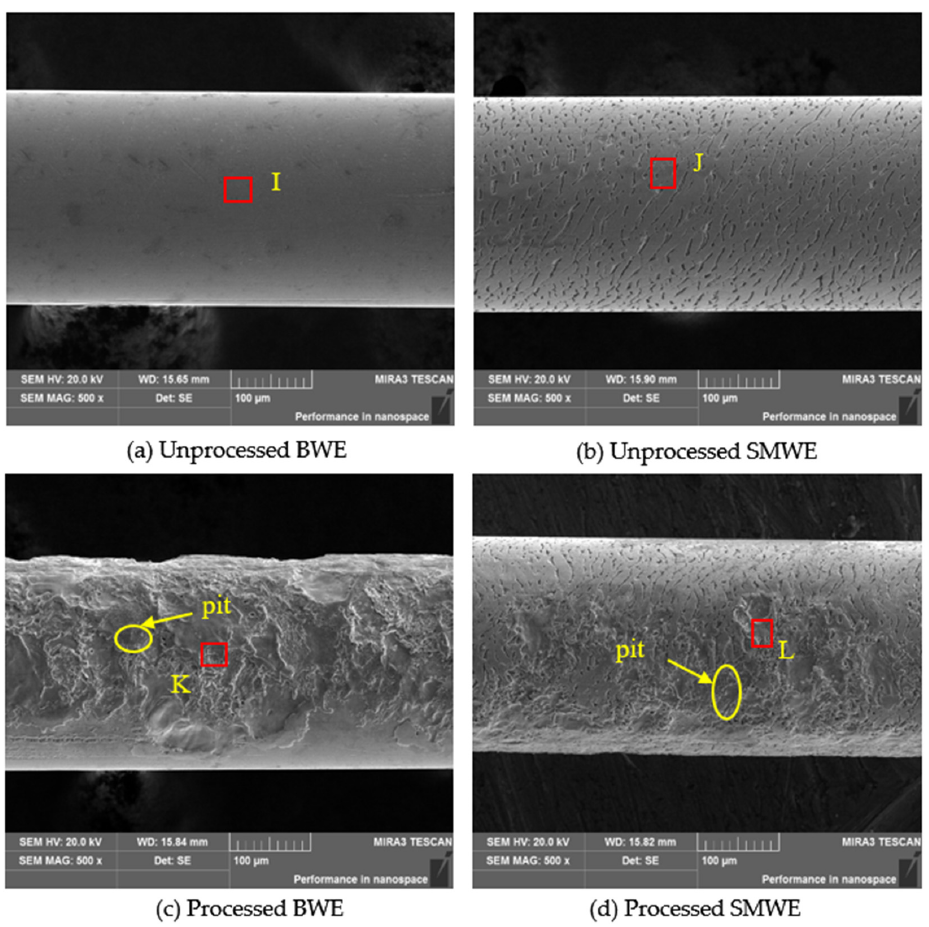
Figure 8. SEM images of the wire electrode surface topography. Table 9. Chemical composition of the wire electrode. Region